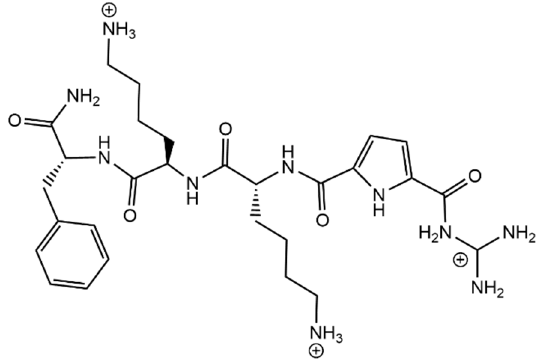
Figure 28. Structure of the peptidyl Guanidiniocarbonyl pyrrole receptor, GCP-KKF [163].